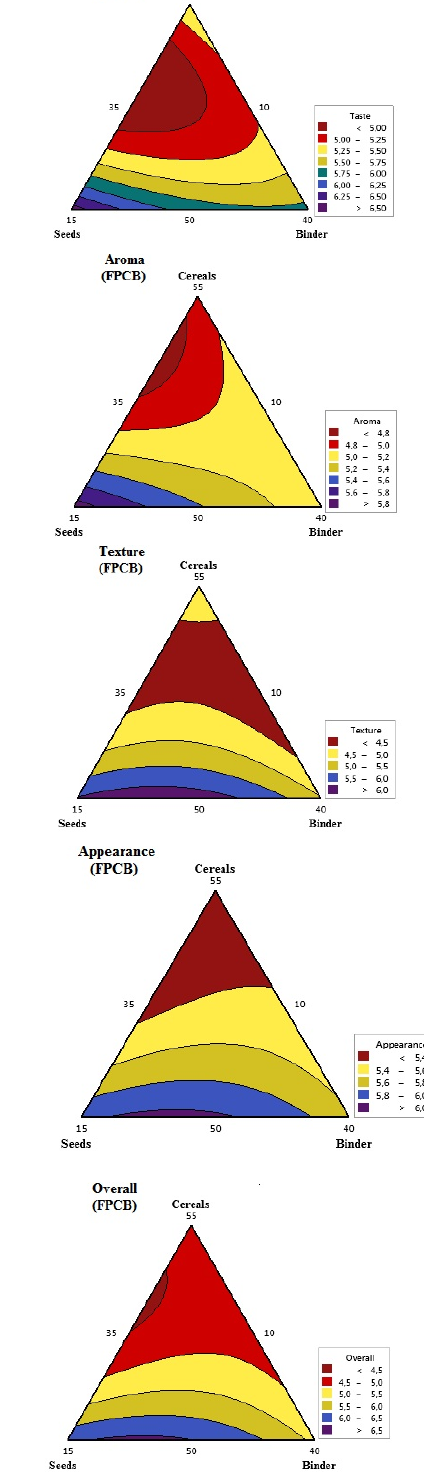
Figure 2. Contour plots for predicted sensorial attributes for gluten-free fiber-rich cereal bars (FNPCB: